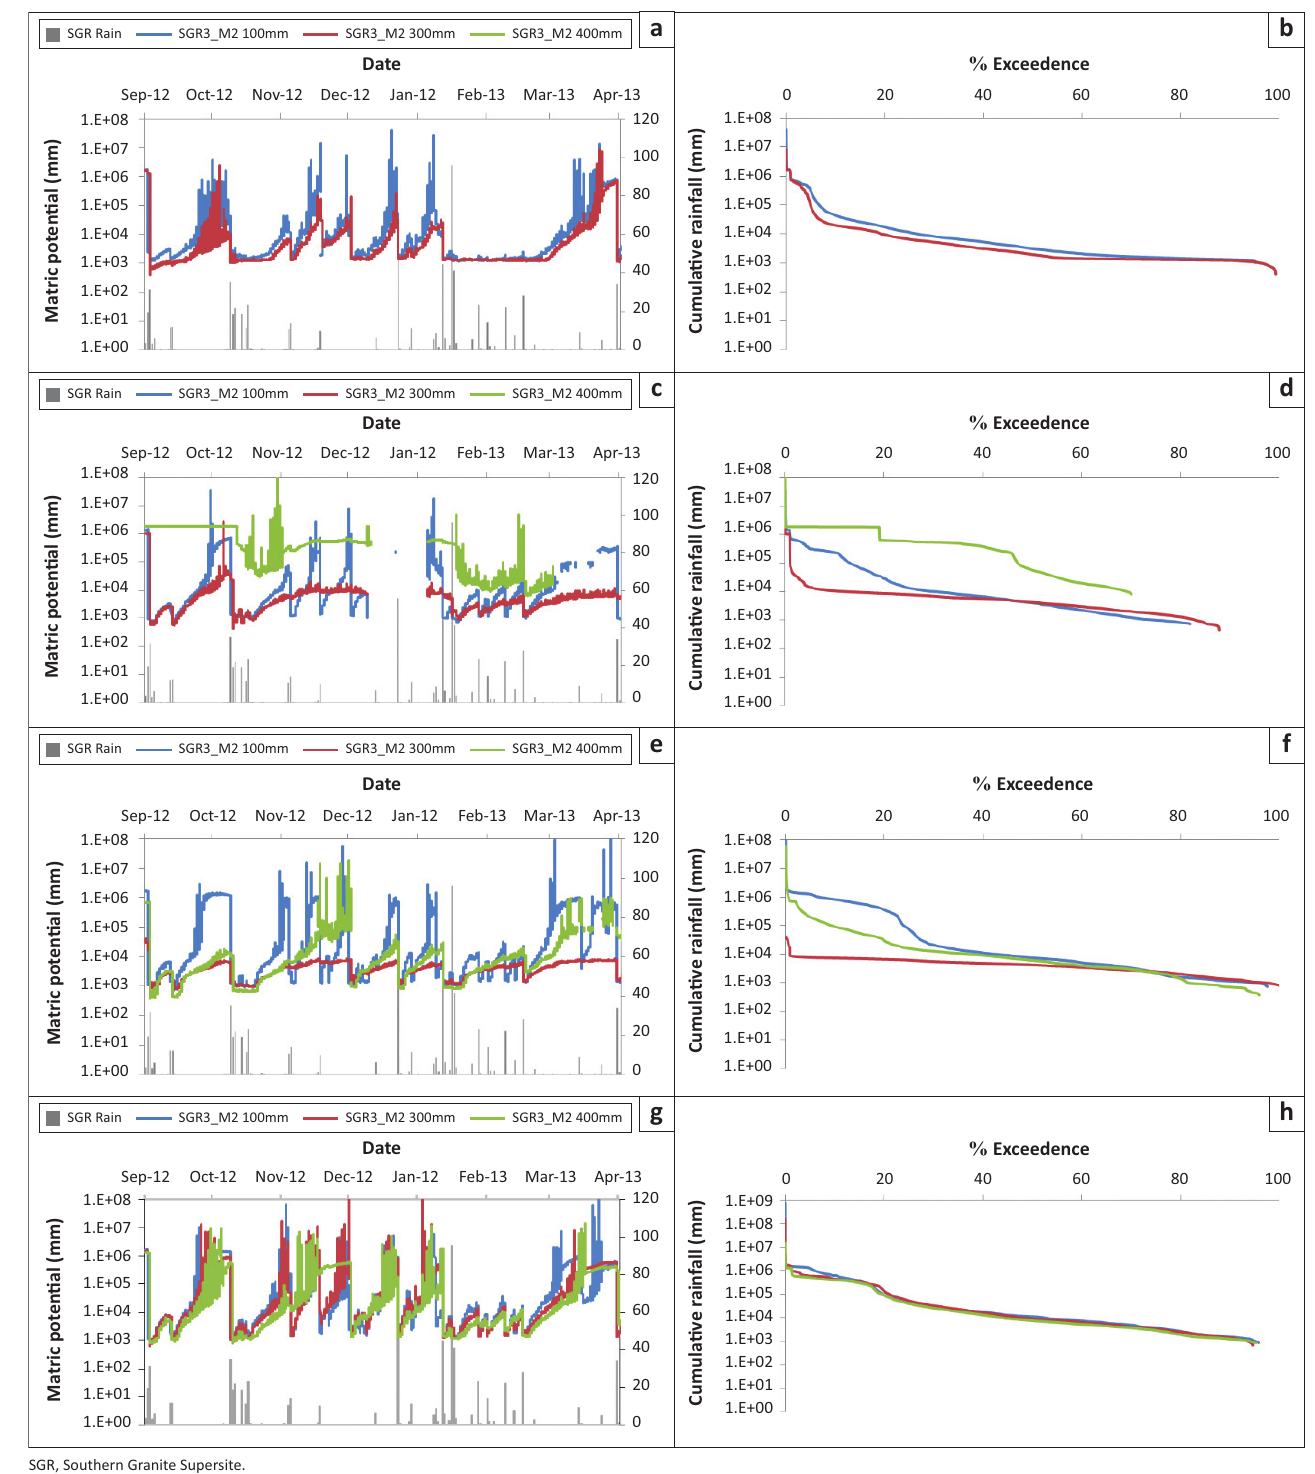
SGR, Southern Granite Supersite. FIGURE 6: Soil matric potential responses and % exceedence curves + at the third-order catena (September 2012–April 2013) ( + note erroneous logger data